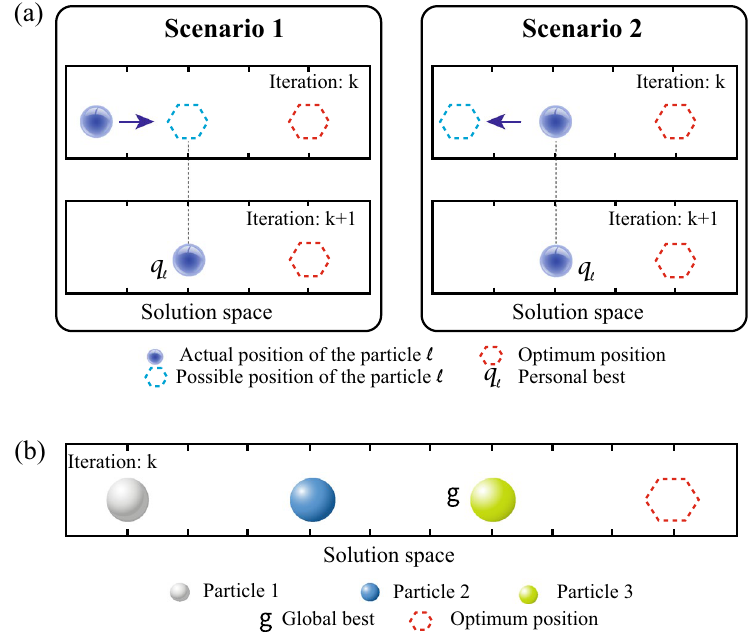
Figure 4. ( a ) Memory attribute of the particle. ( b ) Communication attribute of the